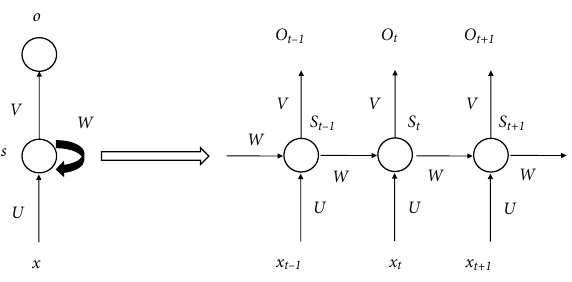
Figure 5: RNN network